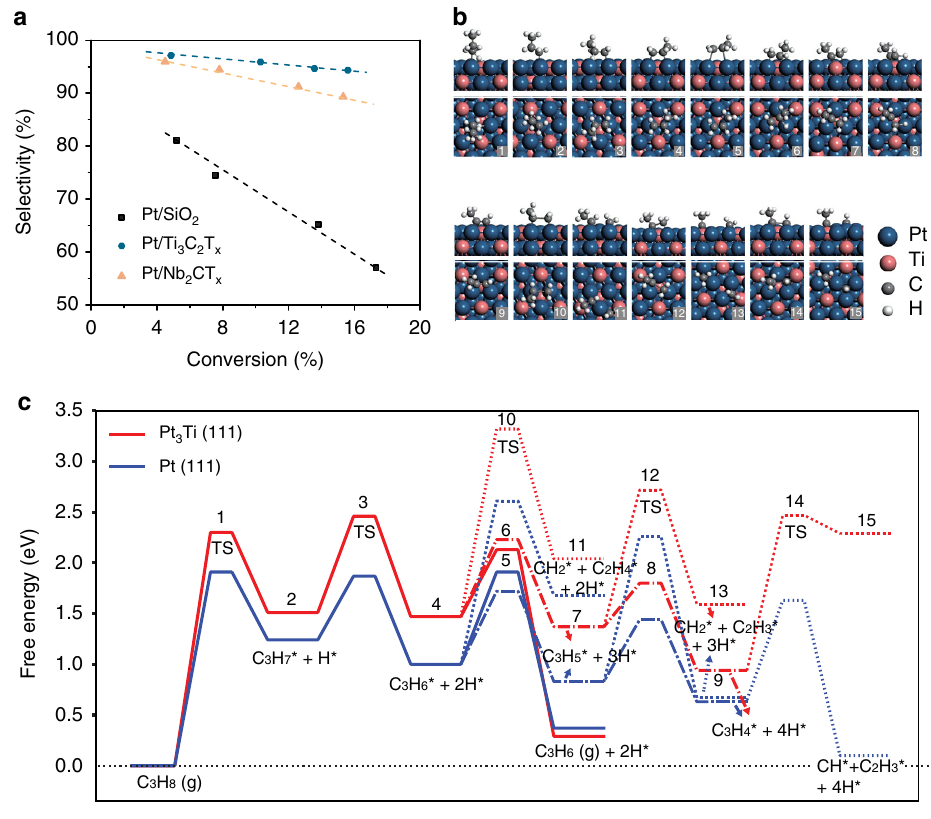
Fig. 4 Catalytic performance and DFT calculation of Pt/MXene catalysts. a Plots of conversion vs. selectivity for propane dehydrogenation measured in 200 cm 3 min − 1 of 2.5% C 3 H 8 , 2.5% H 2 balanced in N 2 at 1.5 atm and 550 °C for Pt/Ti 3 C 2 T x , Pt/Nb 2 CT x , and Pt/SiO 2 catalyst. b Snapshots of optimized structures as numbered in c from side and top view angles (H* is not shown). c DFT-calculated free energy diagram of relevant (side-)reaction steps in propane dehydrogenation on Pt 3 Ti (111) and Pt (111) surfaces. The dotted lines denote the C – C cracking reactions of C 3 H 6 *, C 3 H 5 *, and C 3 H 4 *, generating CH 2 * + C 2 H 4 *, CH 2 * + C 2 H 3 *, and CH* + C 2 H 3 *, respectively. The dash-dot lines denote the further dehydrogenation of C 3 H 6 * to C 3 H 5 *, and C 3 H 5 * to